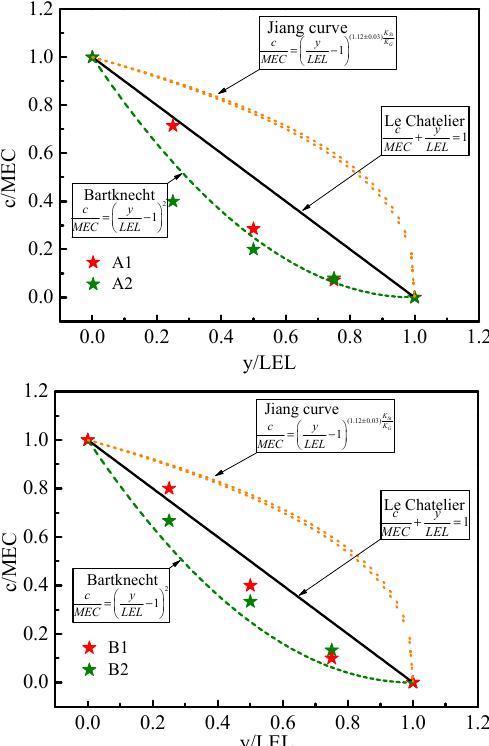
Figure 10. Comparison diagram of lower explosion limit prediction model and experimental results for hybrid mixtures.